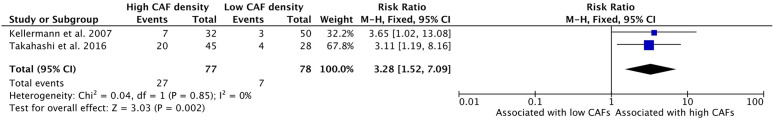
Increased CAF density is associated with high rates of vascular invasion.